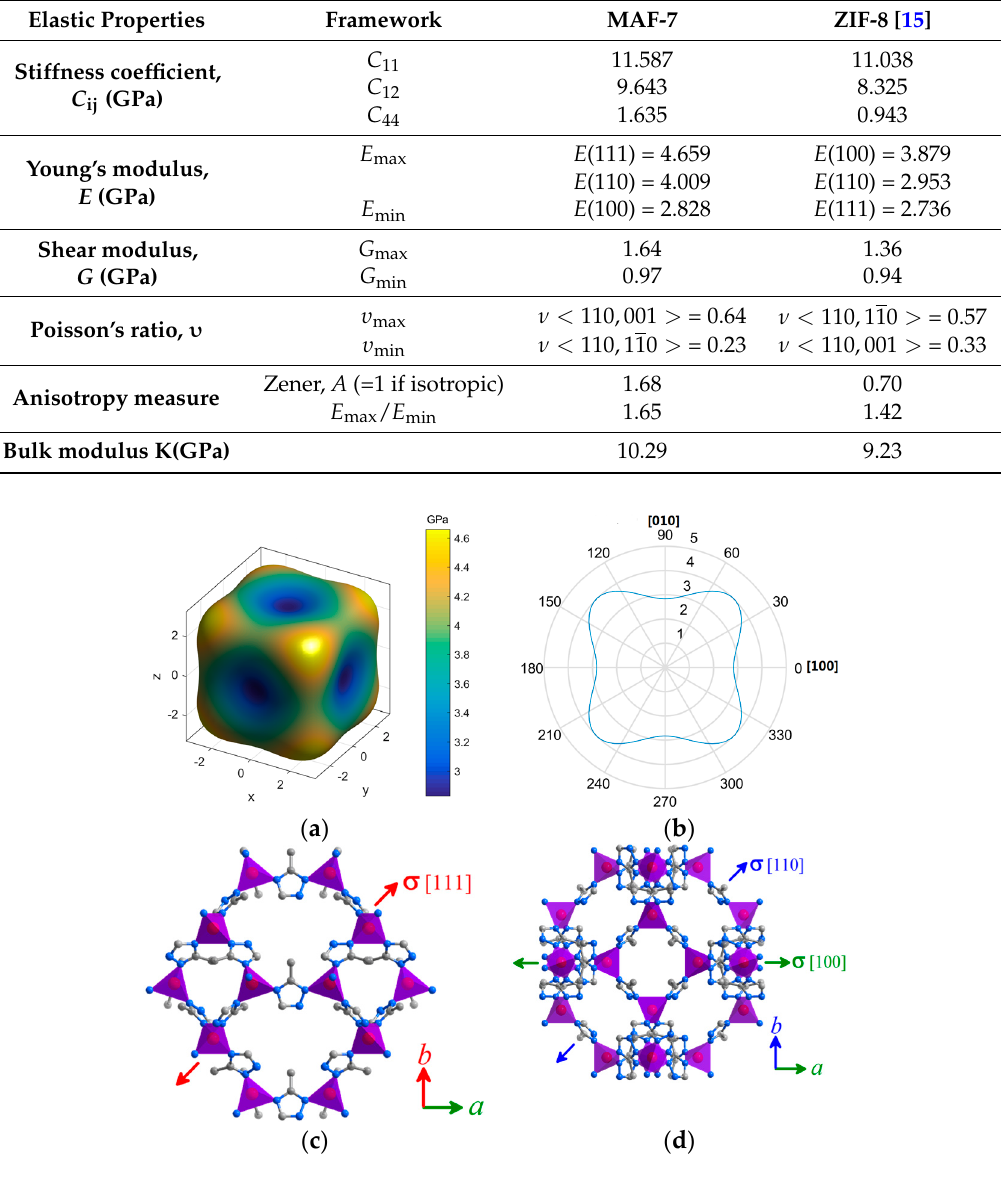
Figure 2. Young’s modulus ( E) representation surfaces. ( a ) 3D and ( b ) 2D surface extracted from the calculated elastic constants. ( c , d ) The schematic of stresses σ applied along [111], [110], [100] directions, corresponding to the maximum, intermediate, and minimum modulus.